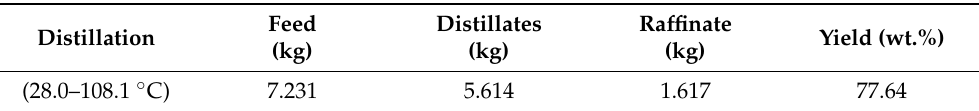
Table 4. Mass balance by fractional distillation of liquid phase products obtained at 420 ◦ C and atmospheric pressure.